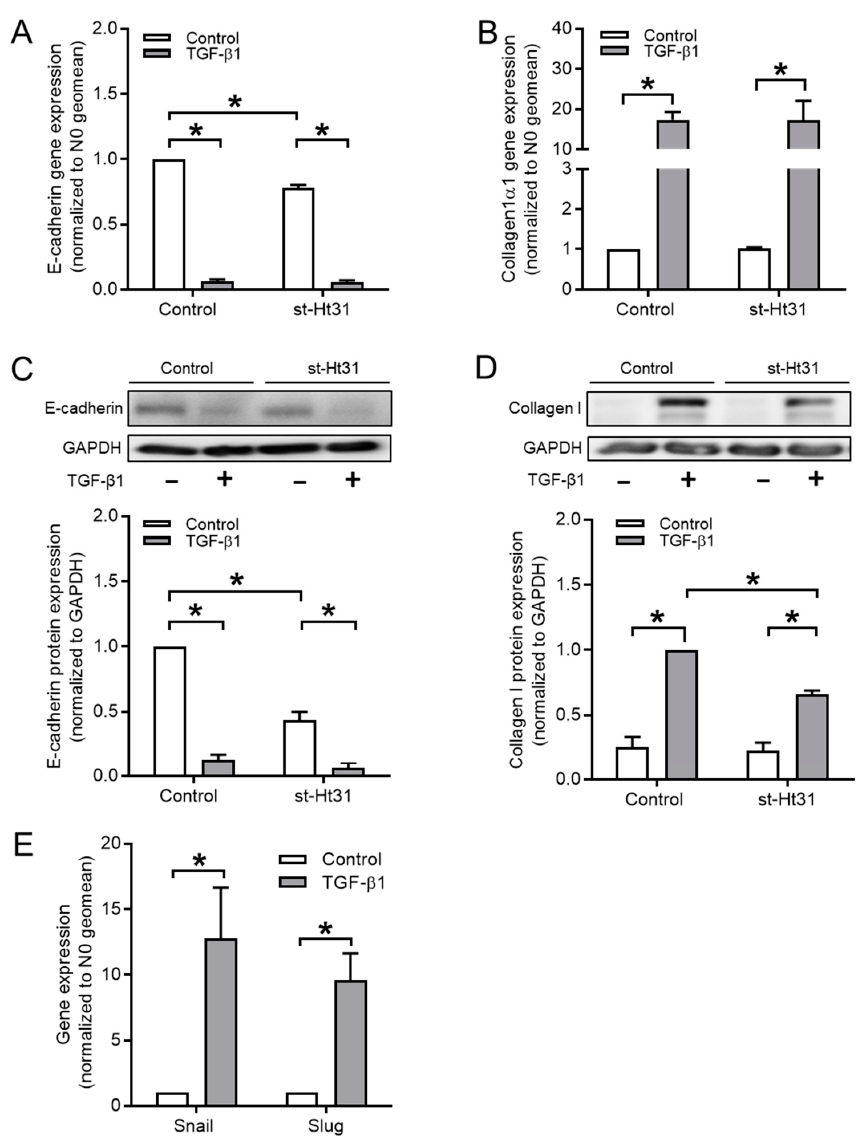
Figure 2. Role of st-Ht31 on EMT markers in BEAS-2B cells. BEAS-2B cells were pre-incubated with 50 µ M st-Ht31 for 30 min., following stimulated with 3 ng / mL TGF- β 1 for 24 h. Gene ( A , C , E ) and protein ( B , D ) expressions of E-cadherin ( A , B ), collagen Ӏ ( C , D ), and Snail and Slug were examined while using real-time quantitative PCR and western blotting, respectively. Data represent three independent experiments. Data are expressed as mean ± SEM, * p < 0.05; significant difference between indicated groups.